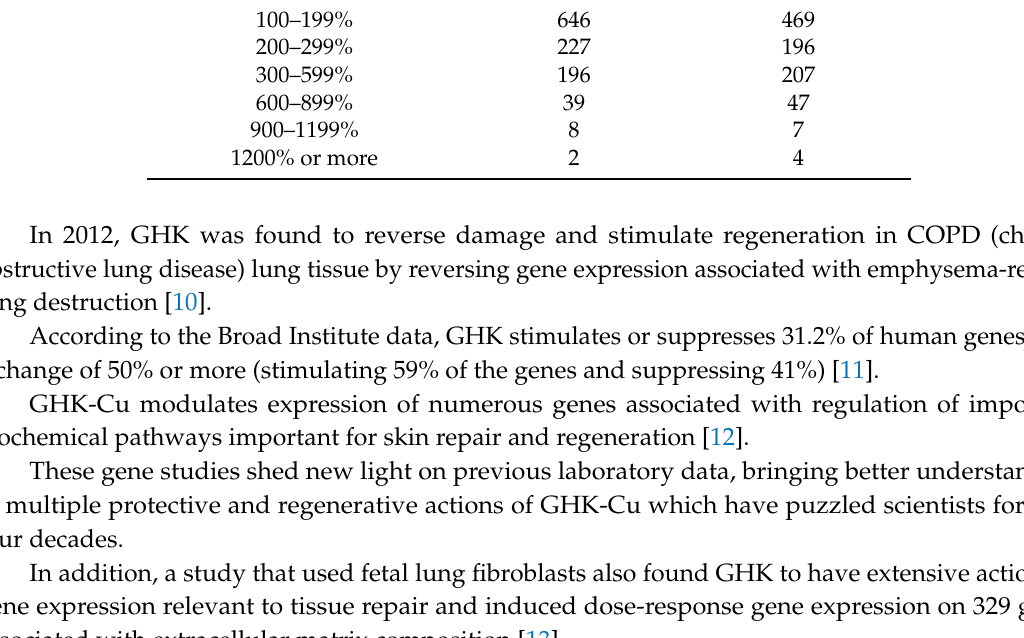
Table 1. Percentage of Genes Affected by GHK. Percentage of